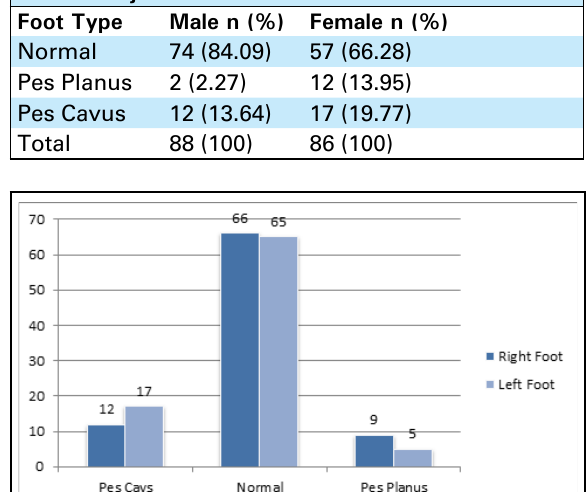
Table 2. Frequency of different foot types in male and female subjects.